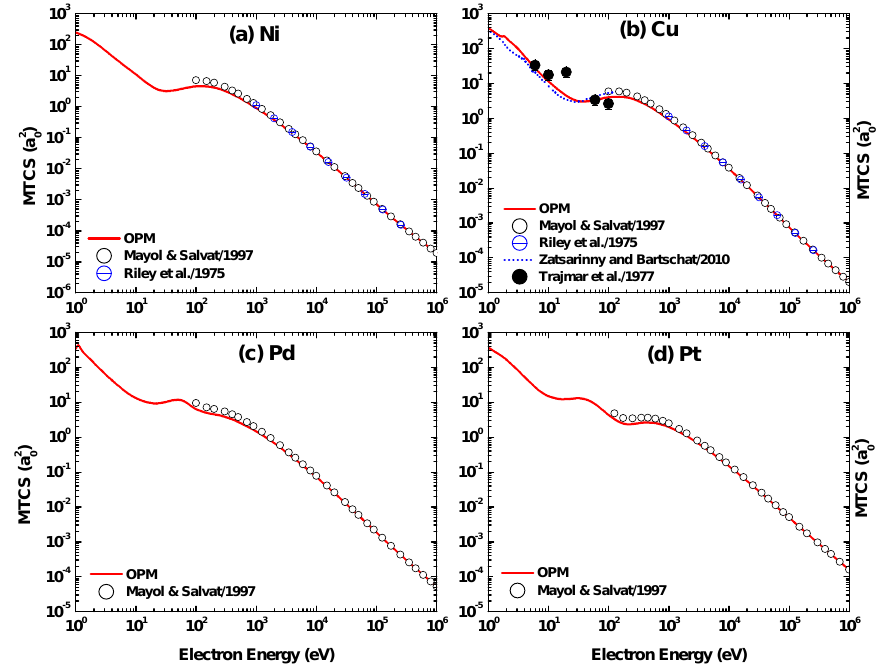
Figure 32. Energy dependence of the momentum-transfer cross-section (MTCS) for electron impact scattering from ( a ) Ni 58 , ( b ) Cu 63 , ( c ) Pd 108 , and ( d ) Pt 196 . Experiment: ( • ) Trajmar et al. [37]. Theory: (——) present OPM approach, ( (cid:13) ) Mayol and Salvat [58], ( (cid:9) ) Riley et al. [40], and ( · · · ) Zatsarinny and Bartschat